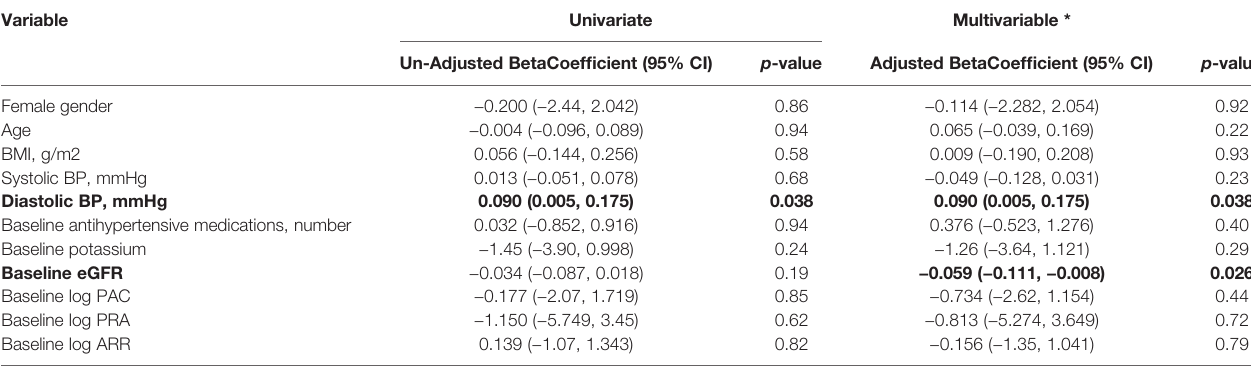
TABLE 2 | Univariate and multivariable linear model of baseline global longitudinal strain (GLS) in all patients treated for primary aldosteronism (n = 45).